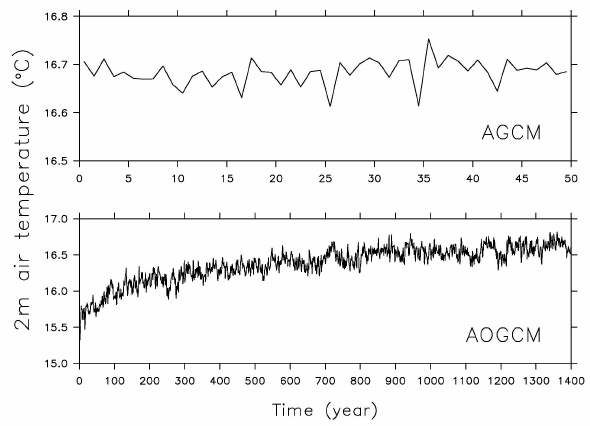
Fig. 6. Time series of the globally averaged value of 2m air tem- perature for the AGCM and AOGCM.